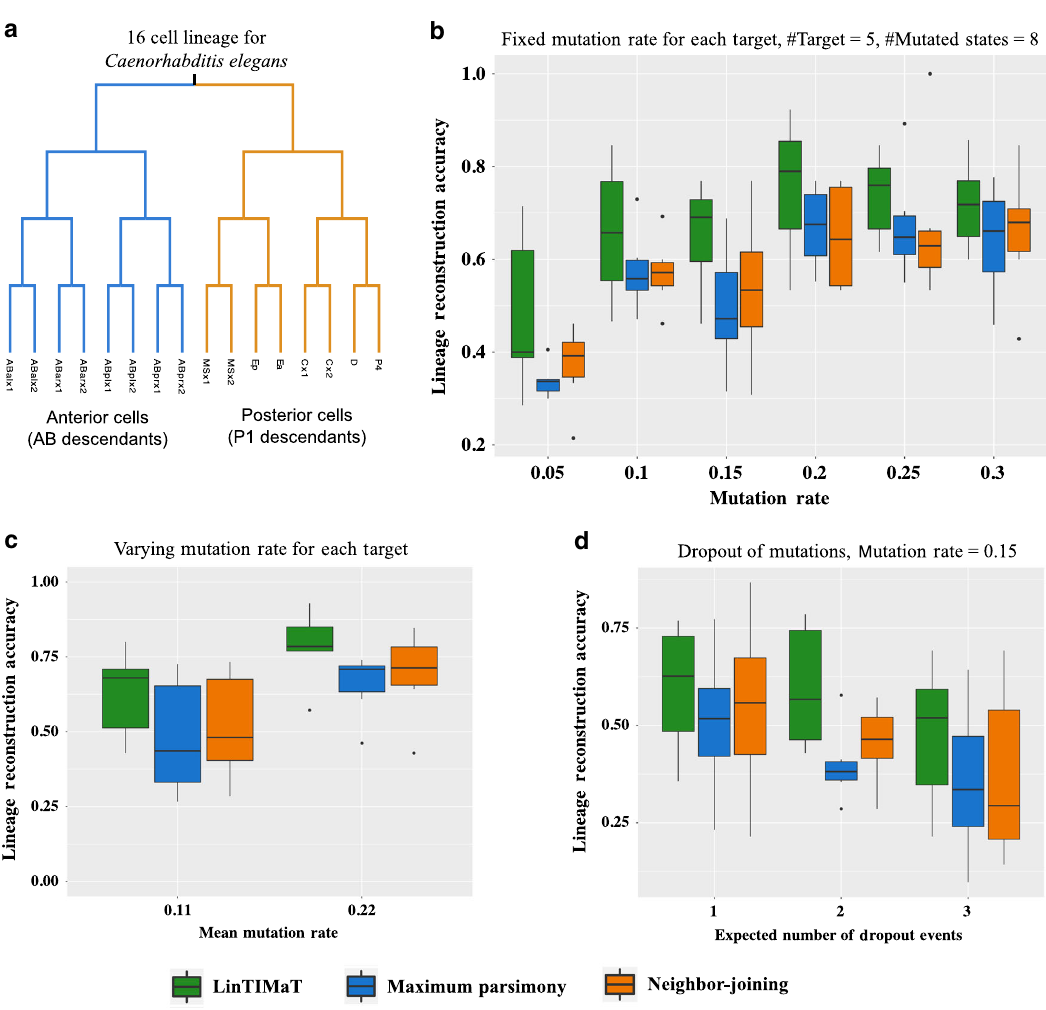
Fig. 2 Benchmarking on C. elegans lineage. a 16-cell embryo lineage for Caenorhabditis elegans . scRNA-seq data for each leaf (cell) was obtained from 27 and included 6 replicates for each cell. b Comparison of LinTIMaT, Camin-Sokal Maximum Parsimony, and Neighbor-joining when varying the mutation rates. The number of possible mutational states was set to 8. Fixed mutation rate was used for each CRISPR target. Each box plot summarizes results for six replicates with varying simulated CRISPR mutation data and experimental scRNA-seq data. c Comparing lineage reconstruction methods when mutation rate varies between different target sites. d Comparison of accuracy of lineage reconstruction by LinTIMaT, Camin-Sokal Maximum Parsimony, and Neighbor-joining in the presence of mutation dropout. Fixed mutation rate, μ = 0.15 was used for all targets. For b – d each box-and-whisker plot summarizes results for six replicates, where the box shows the interquartile range (IQR, the range between the 25th and 75th percentile) with the median value, whiskers indicate the maximum and minimum value within 1.5 times the IQR, also shown are outliers as black